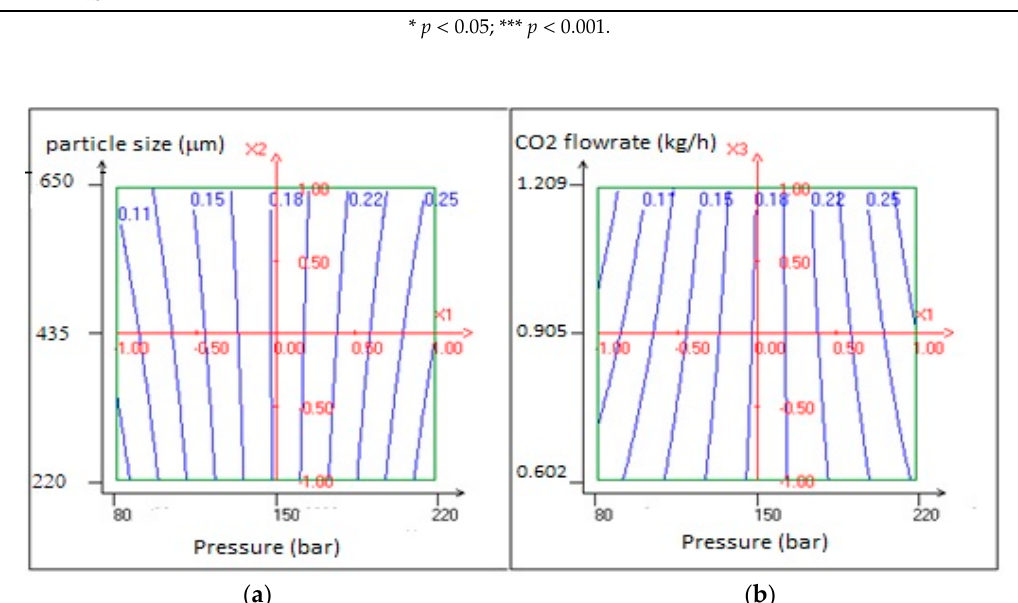
Figure 4. Surface plots of the experimental design yield as a function of ( a ) CO 2 pressure and average particle size ( b ) CO 2 pressure and CO 2 flowrate.